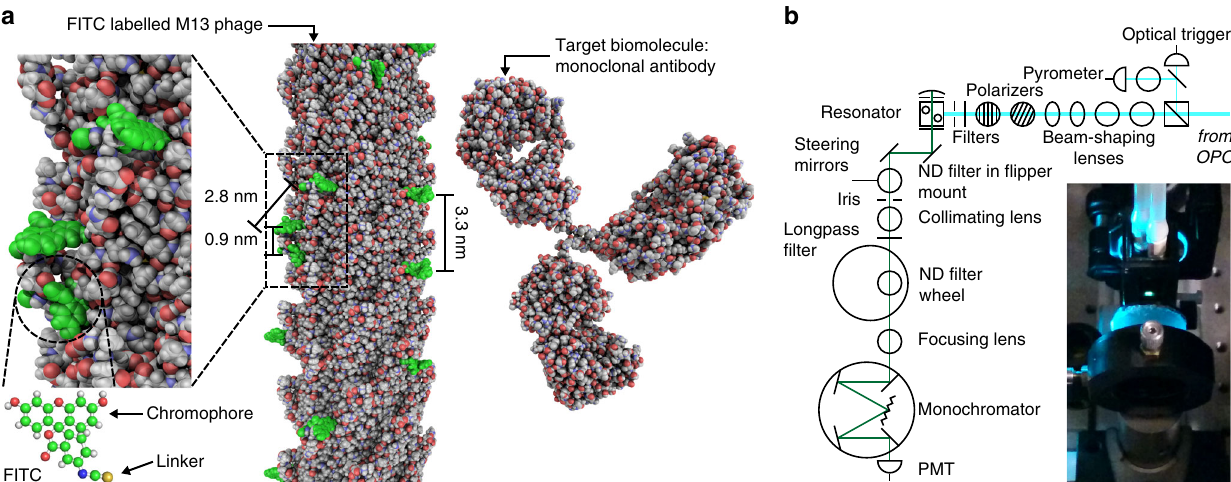
Fig. 1 Design of the virus laser. a Model of the atomic structure of a lasing detection probe composed of M13 bacteriophage (PDB: 2MJZ) covalently modi fi ed with fl uorescein isothiocyanate isomer 1 (FITC) dyes (PubChem CID: 18730, green). 29,57,58 There are ~540 rings of gene 8 coat proteins per M13, but only 13 are shown here. The target biomolecule is a IgG2a monoclonal antibody (mAb) that can be bound by the gene 3 coat proteins and is represented in the fi gure by the structure of an intact IgG2a mAb (PDB: 1IGT) which should have a homologous structure. 59 Rectangular zoomed area, image of the surface of M13 showing the close proximity of the attached dyes. Circular zoomed area, chemical structure of fl uorescein isothiocyanate. Fluorescein has shorter moieties bonded to the aromatic ring system than other xanthene dyes, such as rhodamine 6G, reducing the likelihood of contact quenching between neighbouring dyes. b Optical con fi guration for experiments conducted using resonant cavity R2 (Supplementary Fig. 1). The excitation source was an optical parametric oscillator (OPO), the detector was a photomultiplier tube (PMT) and the emission was attenuated by neutral density (ND) fi lters. Inset, photograph of the emission from the gain medium of the virus laser (green light) as viewed from along the axis of the resonator